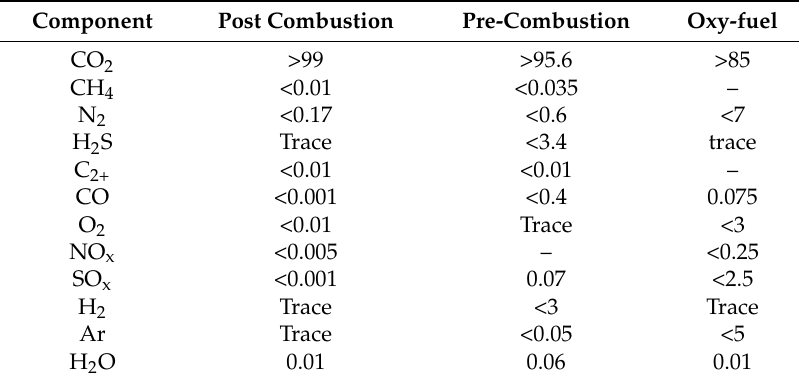
Table 3. CO 2 stream composition for different capture methods (volume%) [34,68].